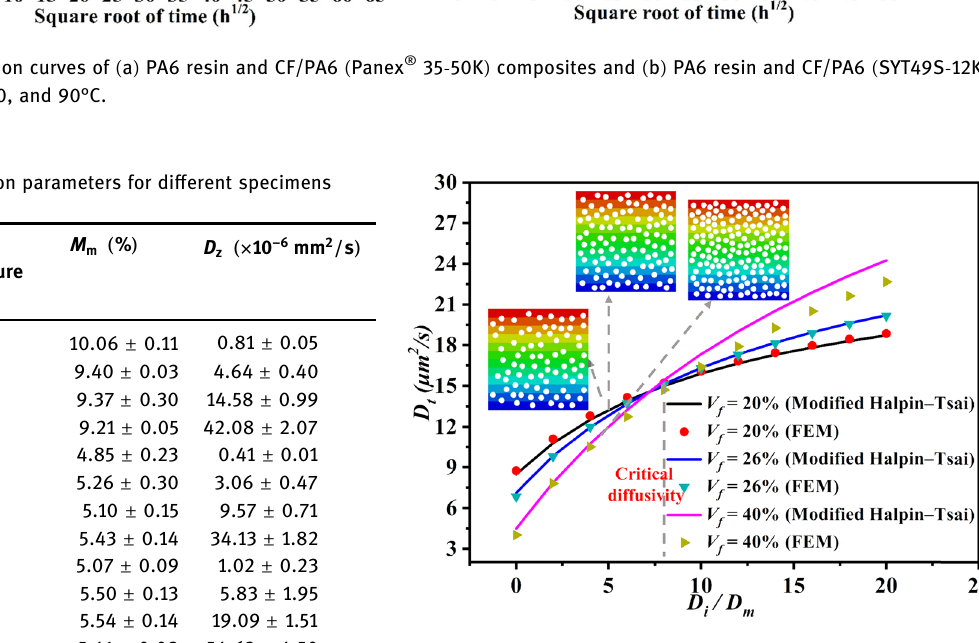
Figure 7: Evolution of transverse di ff usivity of composites ( D t ) vs the ratio of the di ff usivities of the interphase and matrix D D i m ( / ) . Here V f denotes the volume fraction of fi ber and FEM denotes the fi nite element method used to generate the data set.